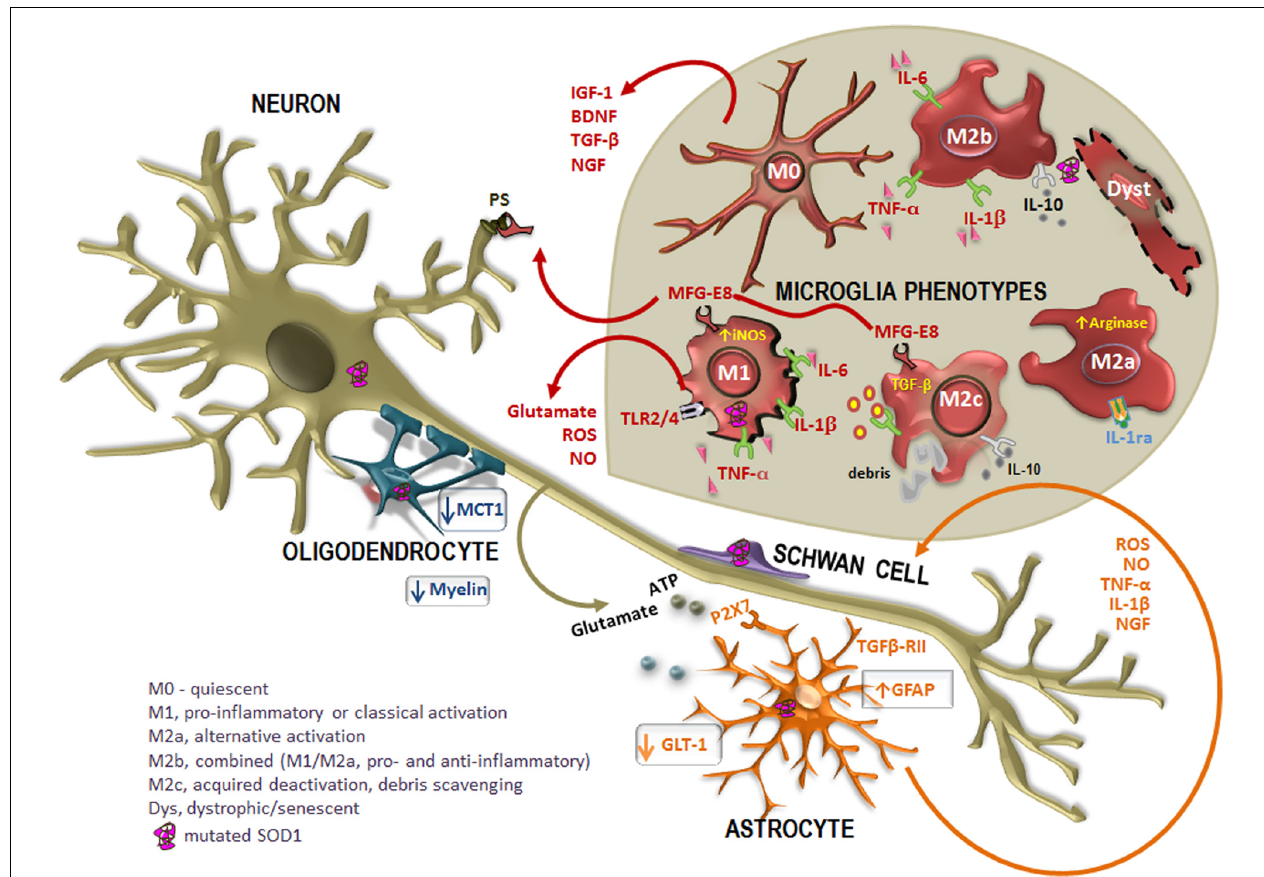
monocarboxylate transporter 1 (MCT1), thus compromising the energy supply to MNs. On the other hand, increased mutated SOD1 expression in Schwann cells may have intricate ways contributing to slow ALS progression. When mutated SOD1 accumulates within microglia, there is a pattern of activation. Microglia acquire different activation phenotypes (M0, M1, M2a, M2b, M2c, and dystrophic/senescent) and, consequently, produce a diversity of substances that may be either beneficial [insulin-like growth factor 1 (IGF-1), transforming growth factor- β (TGF- β ), brain-derived neurotrophic factor (BDNF), and nerve growth factor (NGF)] or toxic (glutamate, ROS, NO) to other cells. Phagocytosis is mediated by the release of milk factor globule-8 (MFG-E8) from microglia M1 and M2c phenotypes that recognizes phosphatidylserine (PS) in apoptotic neurons. Reliable markers for M2a are high IL-1 receptor antagonist (IL-1Ra) and high arginase, for M2b are IL-10, TNF- α , IL-6, and IL-1 β , for M2c are TGF- β and IL-10 and for M1 are TNF- α , IL-6, and IL-1 β , increased inducible nitric oxide synthase (iNOS) and toll-like receptors (TLR)2 and